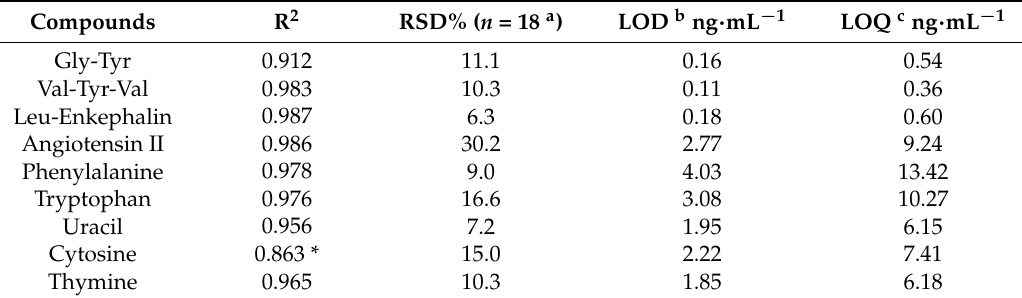
Table 2. Performance hallmarks of the designed trapping-LC